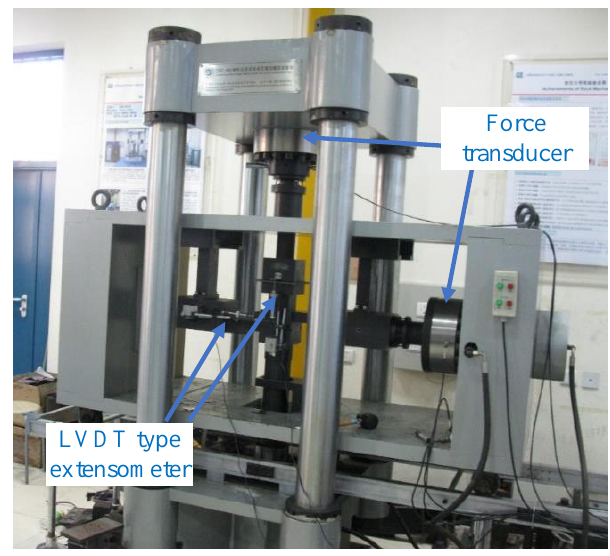
Figure 3. DSC-800 direct shear experimental system with a length of 1.6 m and height of 1.8 m.